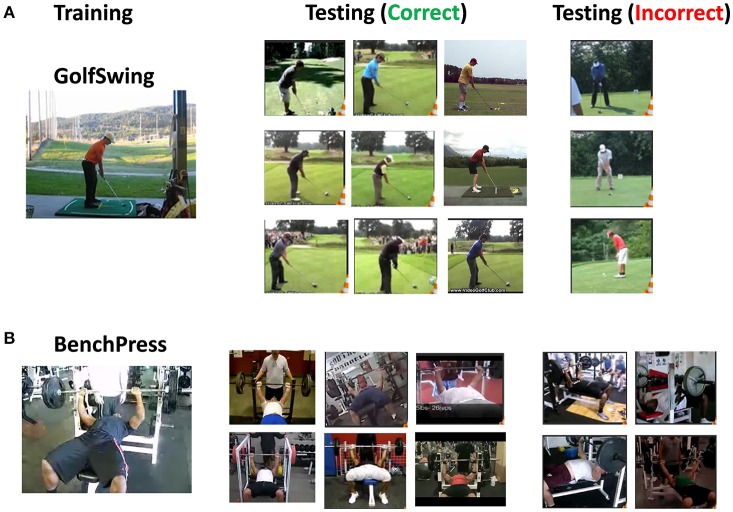
Training/testing video clips of the 2-class problem (A) GolfSwing, (B) BenchPress: Column 1 shows the training video, Column 2/3 show the test video examples correctly/incorrectly classified with our D/A model.